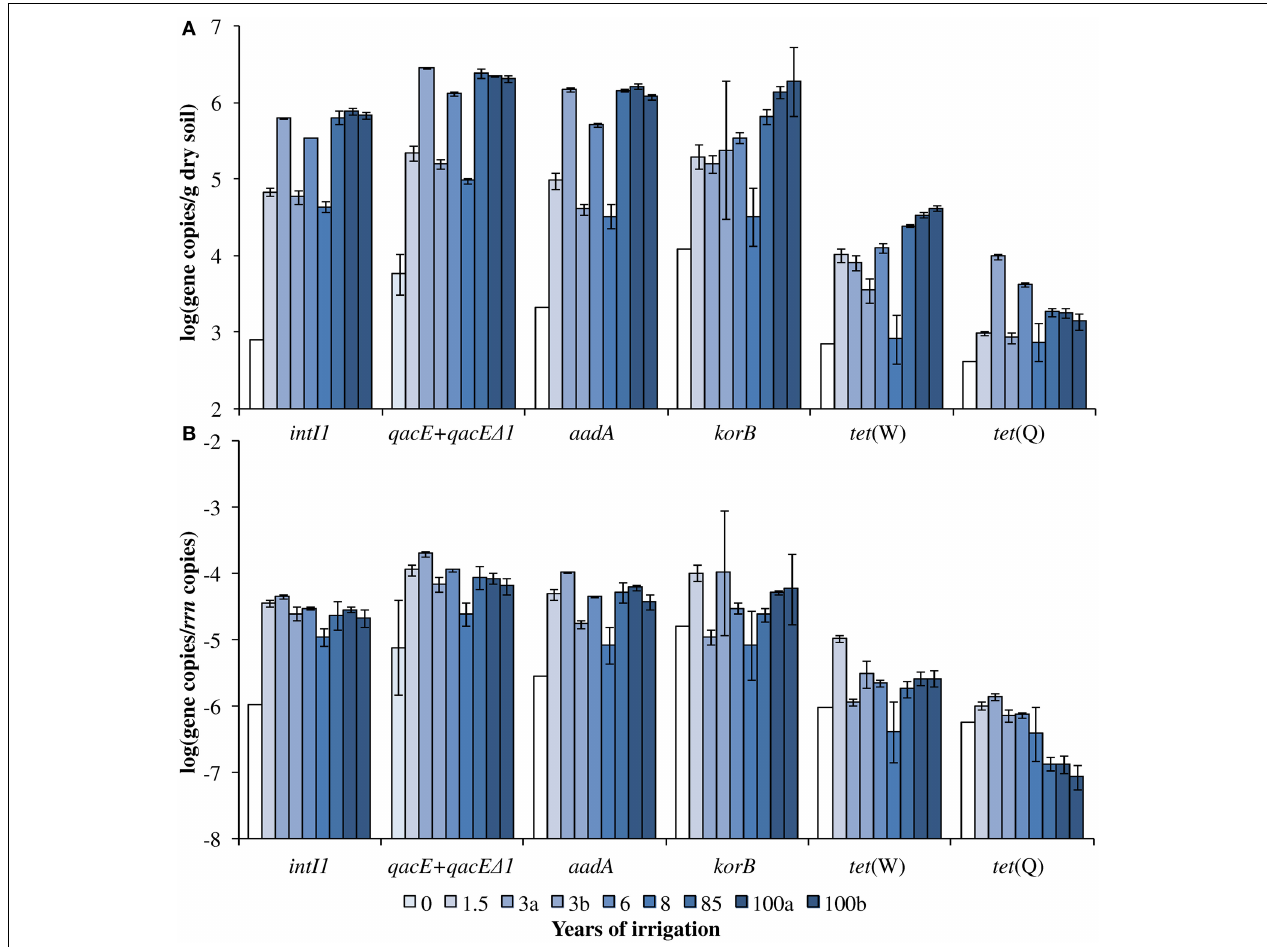
FIGURE 1 | Dry season (A) absolute and (B) relative gene abundance over the period of 100 years of irrigation. Bars and error bars indicate means and respective standard deviations of three technical replicates of one DNA extract from one field, respectively. Fields irrigated for the same period of time are differentiated by small letters (a, b). Except for qacE + qacE (cid:2) 1